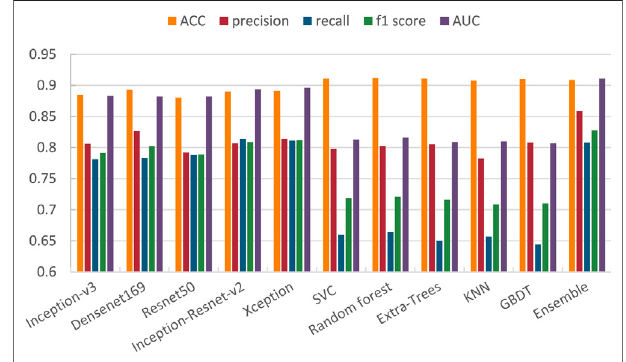
FIGURE 8 | Comparison of different methods on skin lesion classi fi cation.